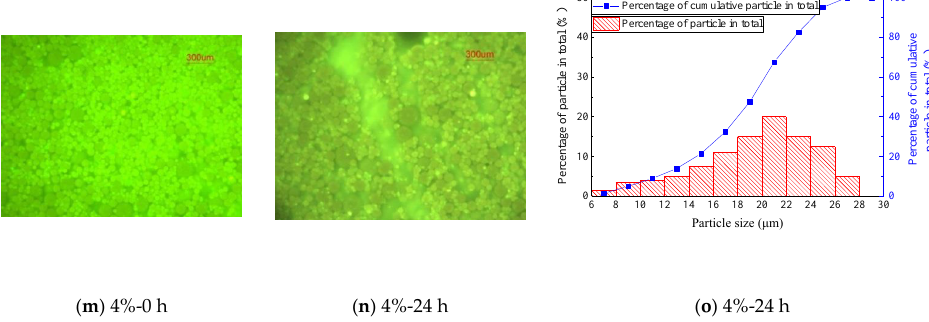
Figure 2. Fluorescence microscope photos and particle size distribution of the WESAE and SBRAE.